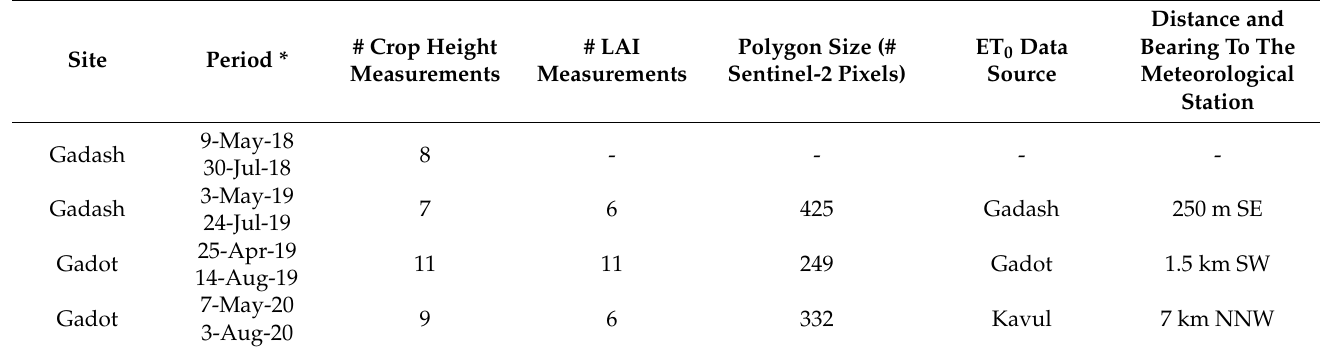
Table 1. The summary of four field experiments conducted in two locations in